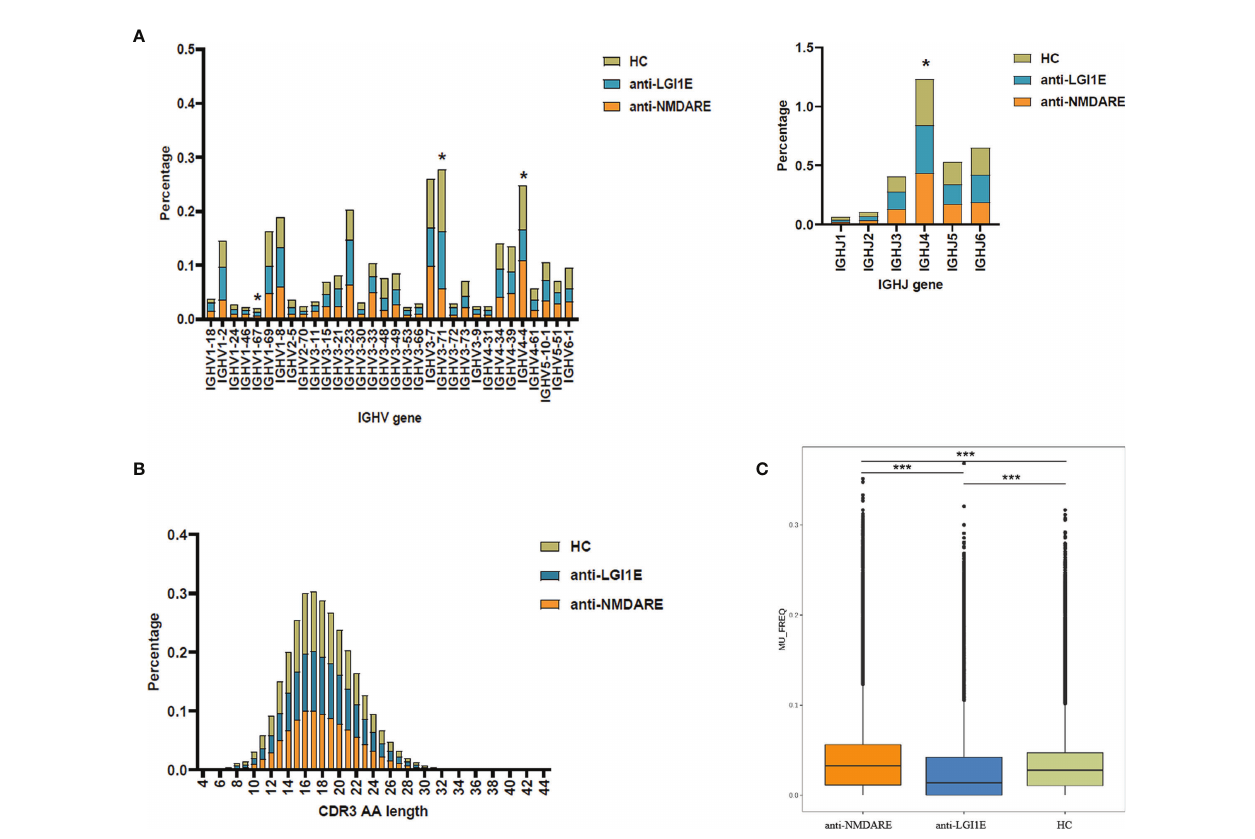
FIGURE 2 | Basic analysis of the B-cell immune repertoire in peripheral blood samples from the anti-NMDARE, anti-LGI1E, and HC groups. (A) Analysis of IGHV and IGHJ gene usage preferences. (B) Analysis of the CDR3 amino acids length. (C) Analysis of the somatic hypermutation rate. Anti-NMDARE, anti-N-methyl-D- aspartate receptor encephalitis; anti-LGI1E, anti-leucine-rich glioma-inactivated 1 encephalitis; HC, healthy control; AA, amino acids. * P adj < 0.05, *** P adj <